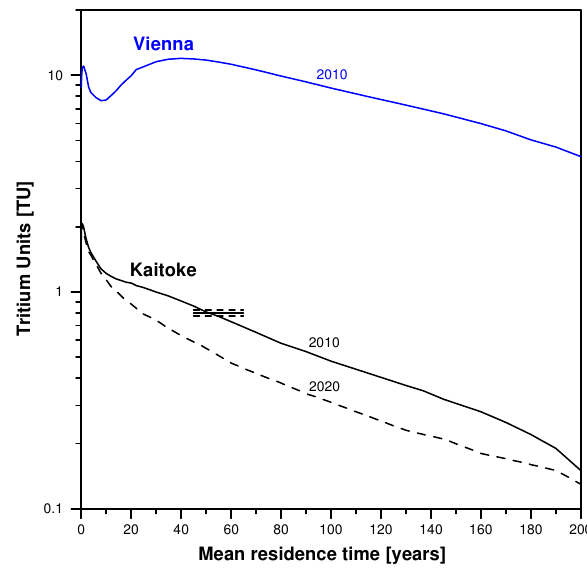
Fig. 2. Tritium output for a typical transfer function of 80% expo- nential flow within an exponential piston flow model for the Kaitoke (New Zealand) and Vienna (Europe) tritium inputs. Solid lines are current tritium outputs for the year 2010. The predicted output for Kaitoke for 2020 (dashed line) is shown for comparison.